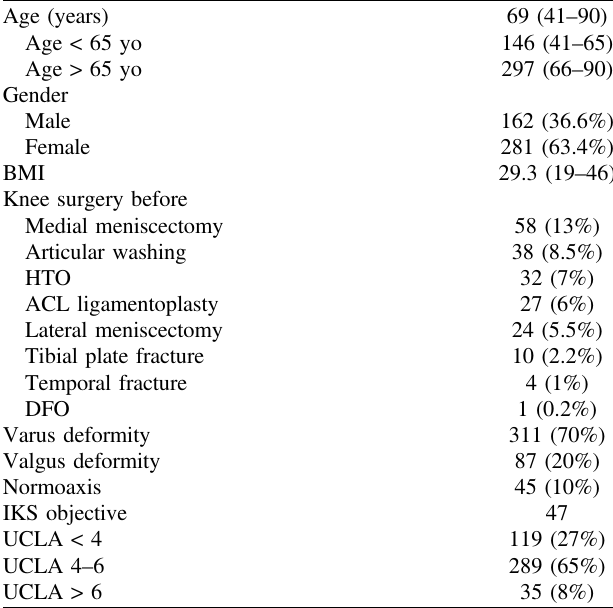
Table 1. Sample characteristics and